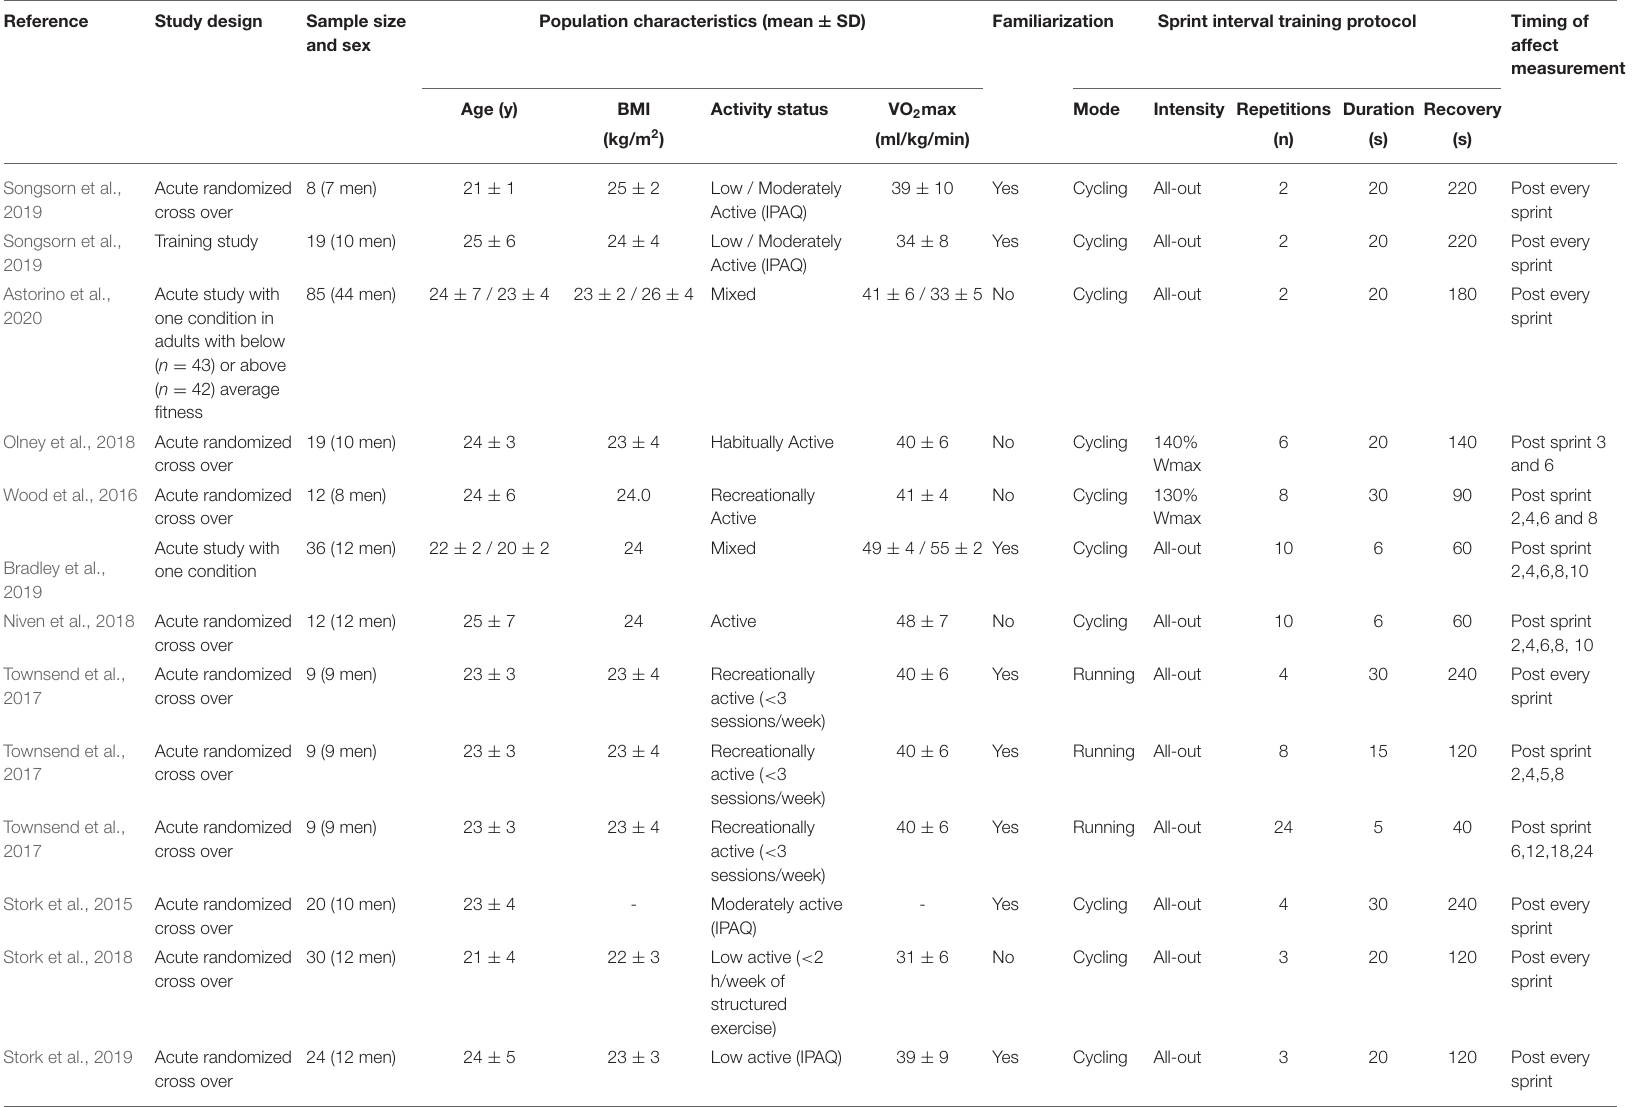
TABLE 1 | Descriptive overview of studies investigating affective responses to SIE using the feeling